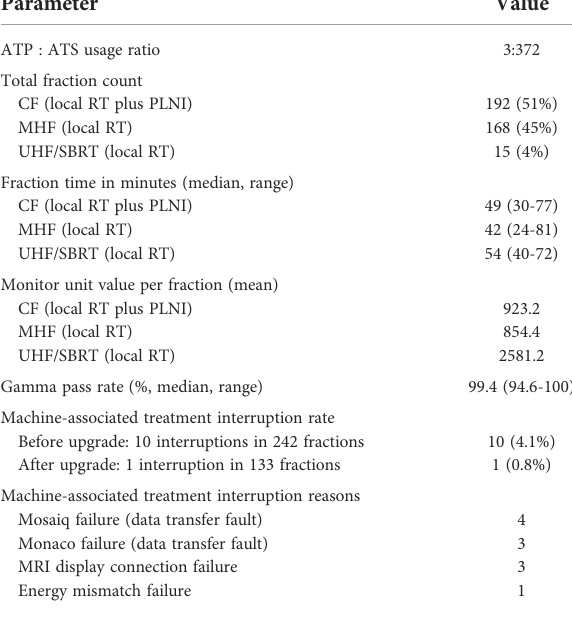
TABLE 3 Technical data for prostate radiotherapy with 1.5 T MRI LINAC. Parameter